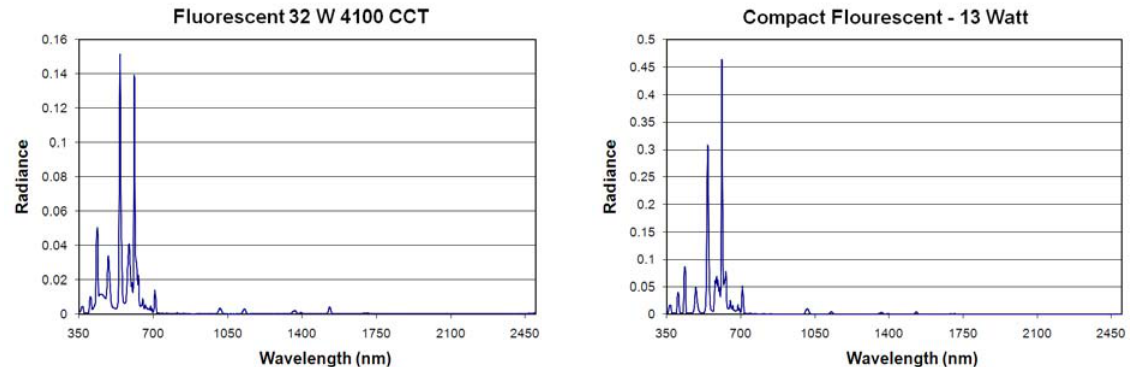
Figure 9. Emission spectra of a standard fluorescent tube and an compact fluorescent light (CFL).